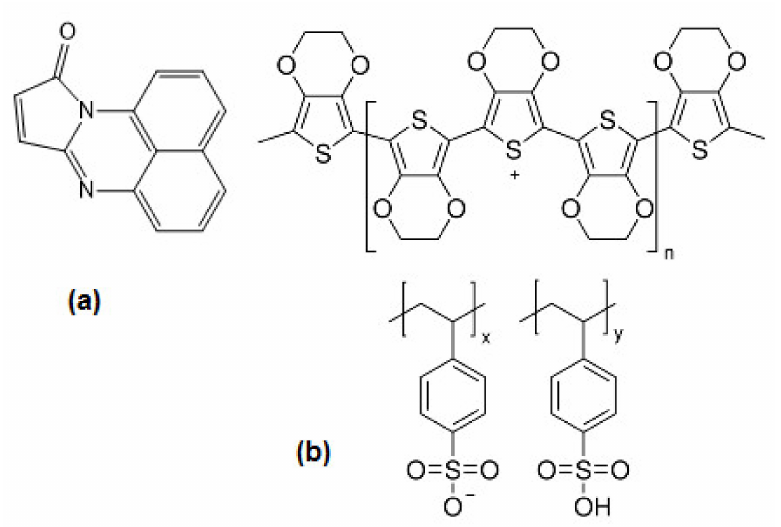
Figure 1. Structure of the ( a ) MP and ( b )